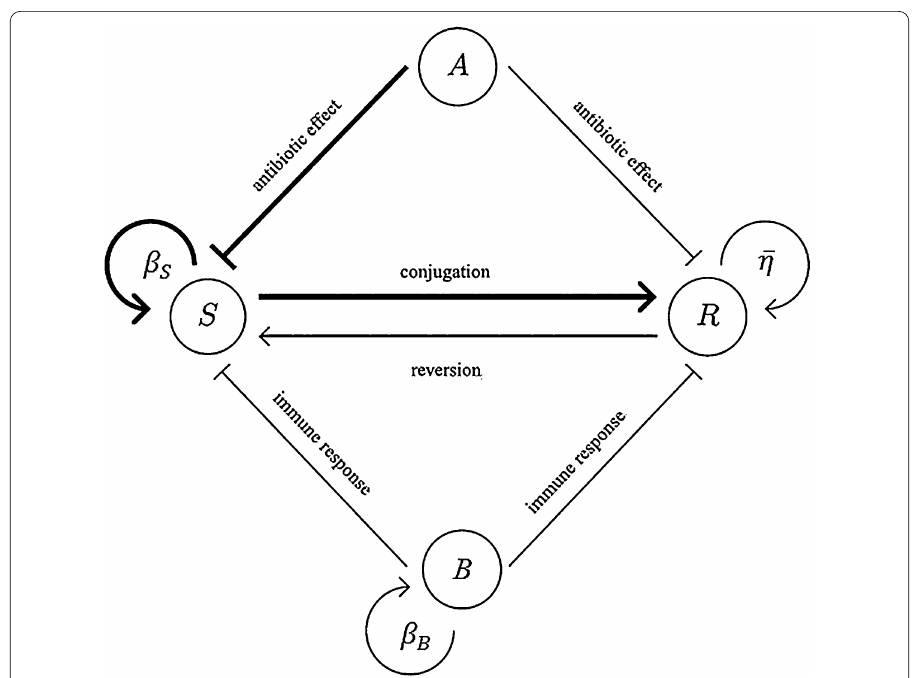
Figure 1 The flowchart of model (1) (as a modification from [5]).